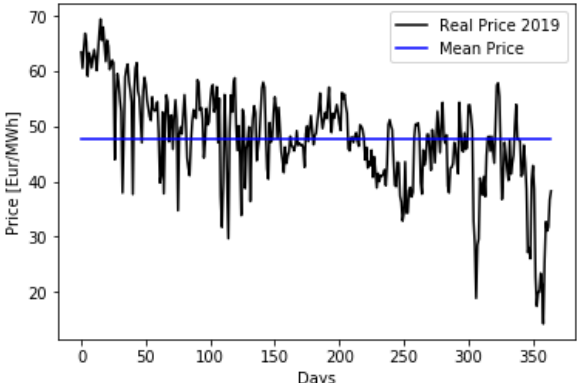
Figure 5. Eeal electricity prices in MIBEL for 2019 and the yearly average price.